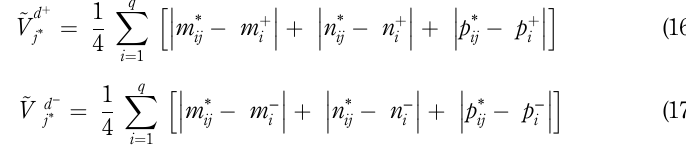
~ ~ d þ from FPIS and V d − FNIS of each V j * j *